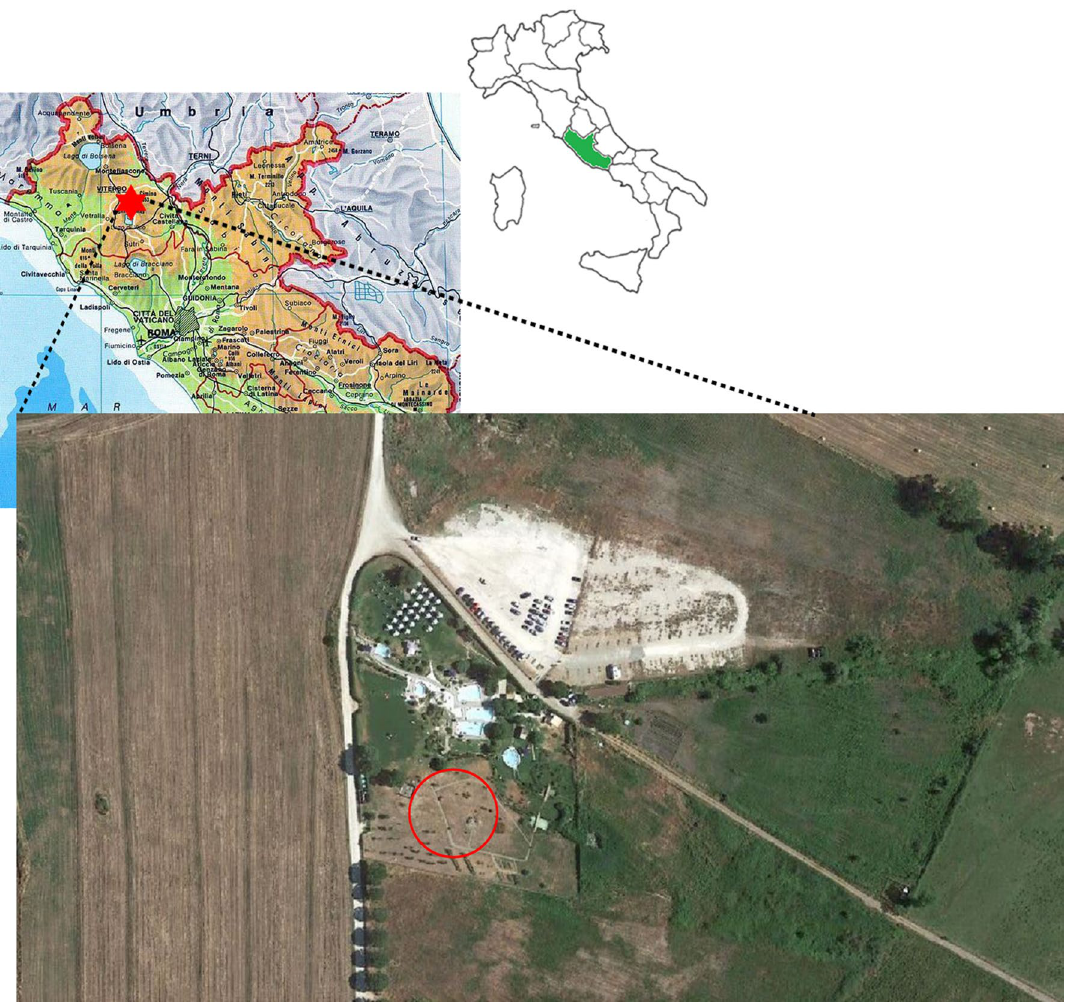
Figure 3. Location of the Bagnaccio soil used in this study. A detailed map of the Lazio region (in green in the map of Italy) is shown and the Bagnaccio area is indicated by a star. The circle on the enlarged image indicates the specific soil under